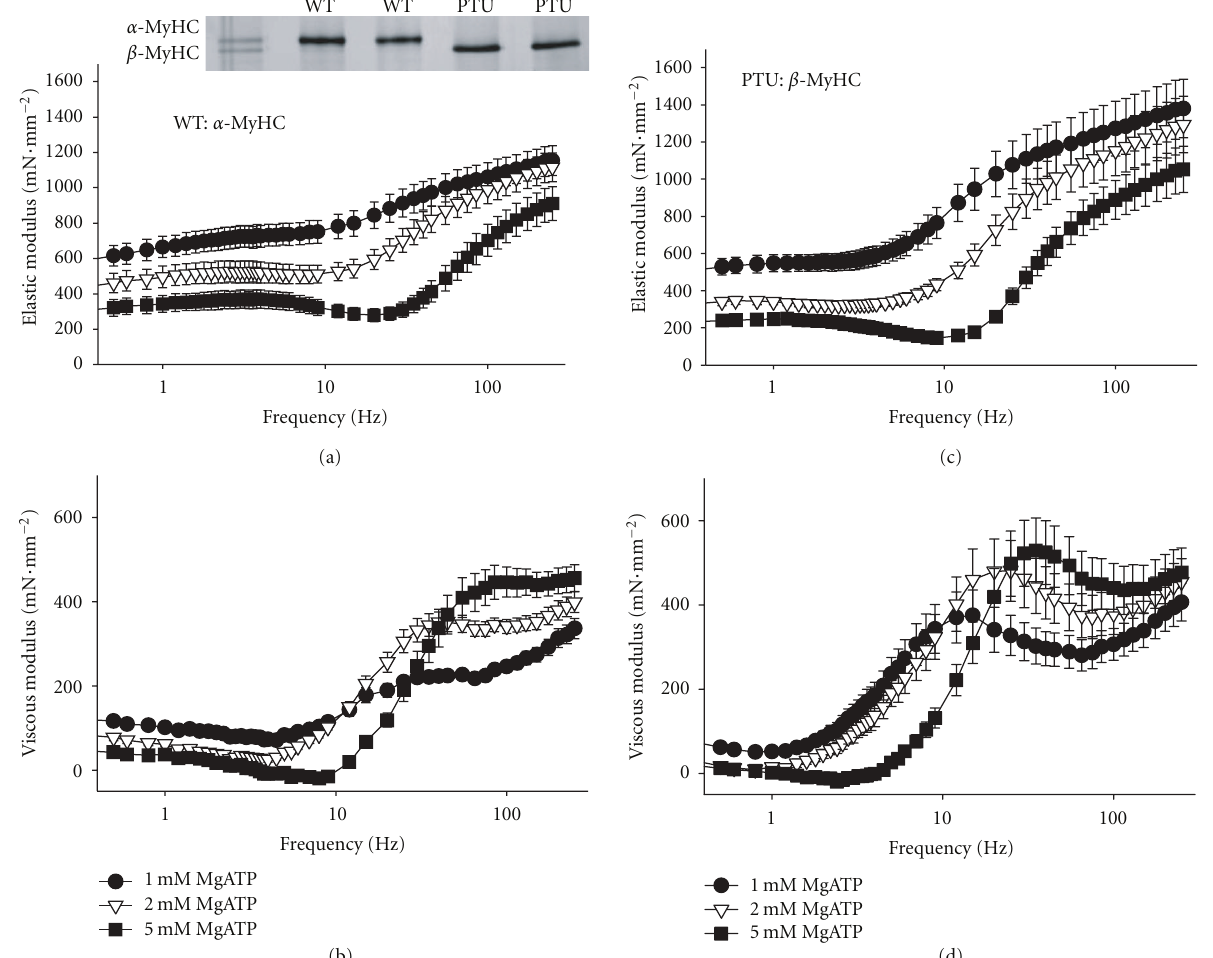
Figure 5: Example elastic and viscous moduli from mouse cardiac muscle strips. (a, b) The elastic and viscous moduli recorded at frequencies ranging 0.125–250 Hz for wild-type mouse cardiac muscle expressing α -MyHC at maximum calcium activation and 37 ◦ C. The frequency characteristics of the dips and shoulders are reflective of the underlying enzymatic activity and shift to lower frequencies as MgATP is reduced from 5 to 1mM. (c, d) The elastic and viscous moduli recorded for PTU-fed mouse cardiac muscle expressing β -MyHC. Frequency characteristics appear at lower frequencies compared to α -MyHC. Again, characteristics shift to lower frequencies as MgATP is